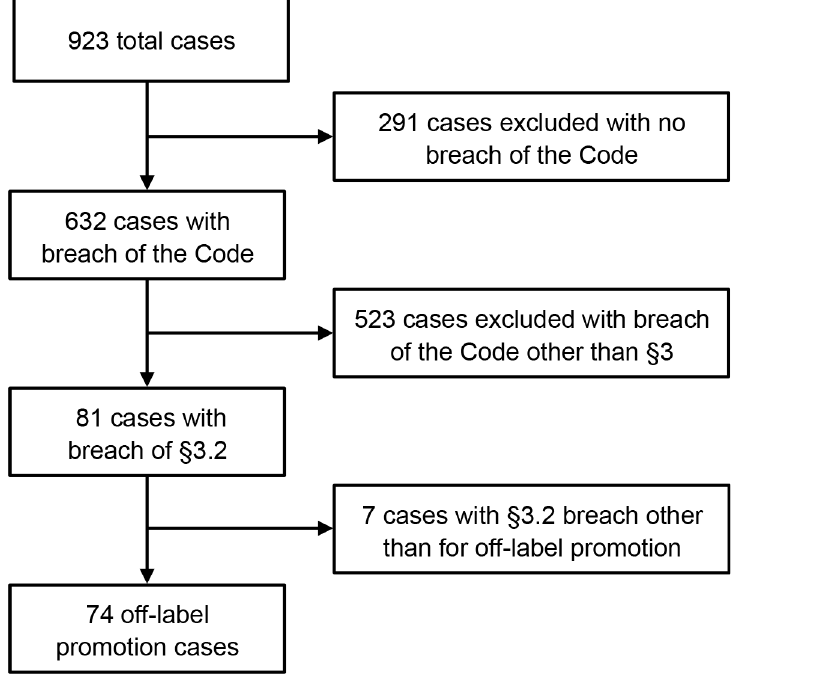
Fig 1. Flow diagram of selected